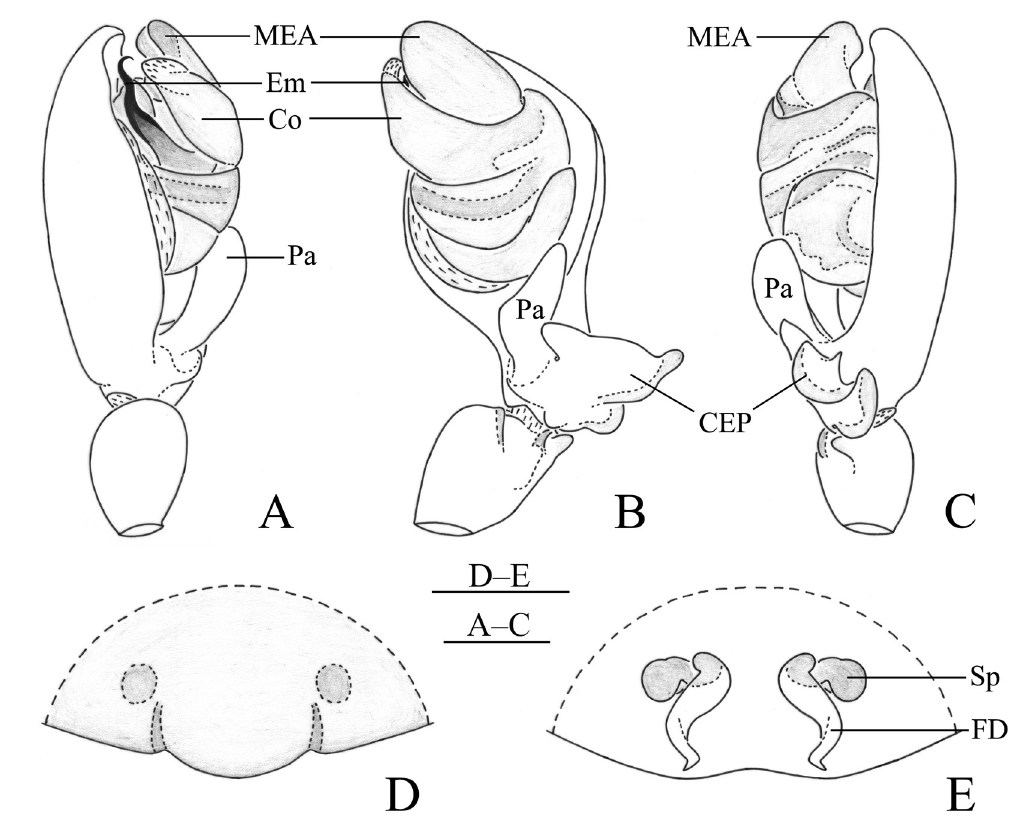
Fig. 4. Meta hamata sp. nov., left palp of holotype ♂ (A–C); epigyne (D) and vulva (E) of paratype ♀ (HNU-CGY25): A . Prolateral view. B . Ventral view. C . Retrolateral view. D . Epigyne, ventral view. E . Vulva, front view. Scale bars: 0.2